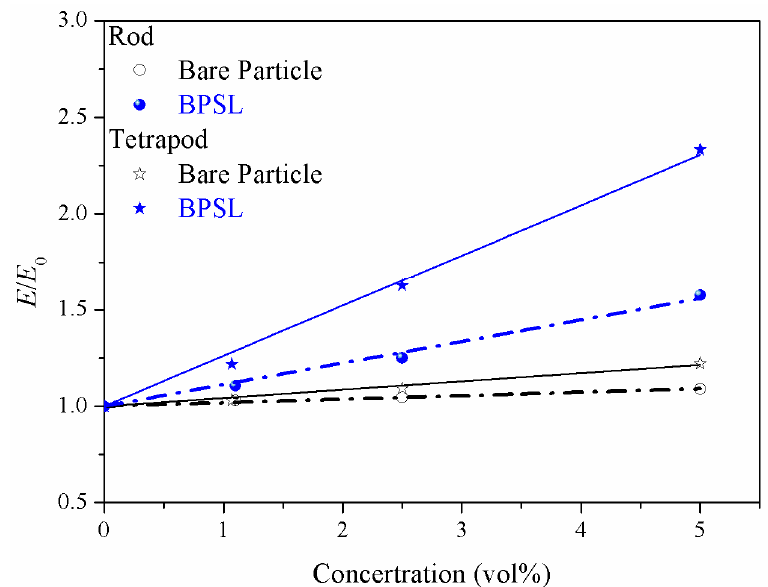
Figure 5. Comparison of bare particles with BPSL (Branched particles with surface ligands) on the relative elastic modulus of composites by lattice spring model. Plot of relative elastic modulus versus nanoparticle concentration. Blue lines represent results from BPSL filled composites, while black lines represent results from bare particles filled composites.